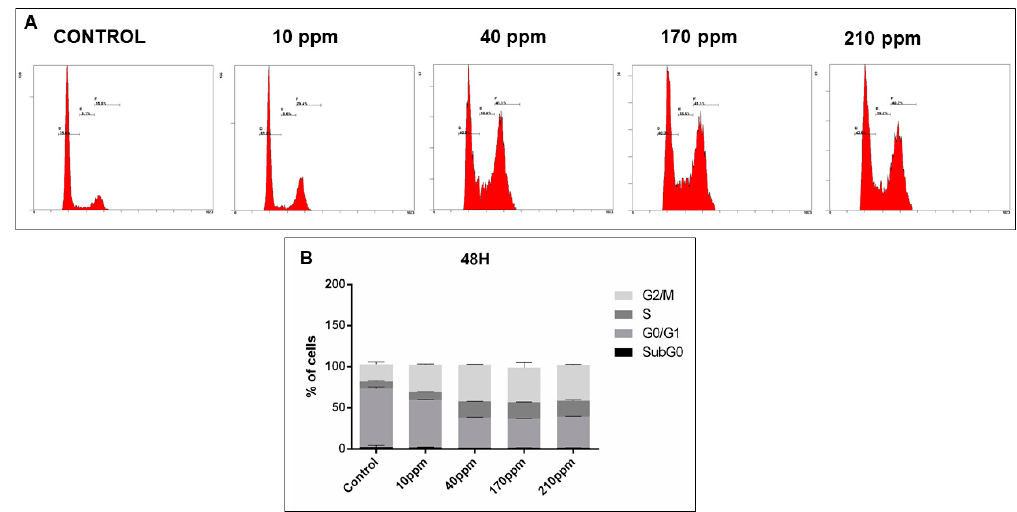
Figure 13. Cell cycle analysis, of PC-3 cells treated with different concentrations of AgNPs for 48 h, assessed using a PI stain and flow cytometry. ( A )—Representative DNA histograms images. ( B )—Quantitative analysis of PC-3 cells AgNPs treated. Data is expressed as mean ± SEM.